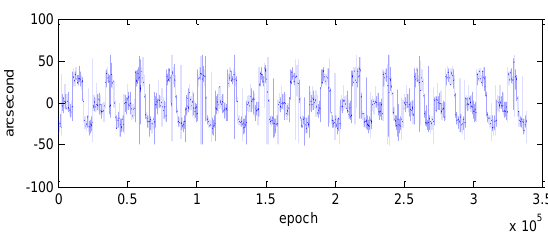
Figure 2. Chart of multiple orbits’ A and C star sensor optical